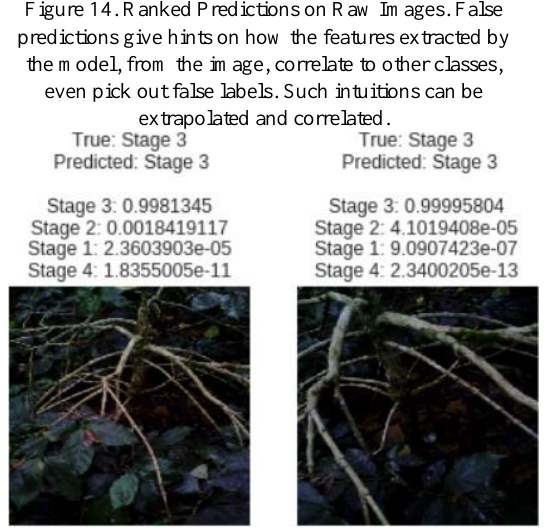
Figure 15. Ranked Stage Predictions on Processed Images